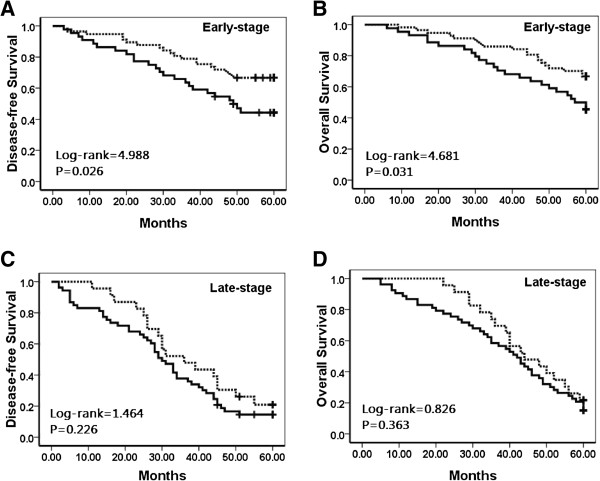
Kaplan–Meier analysis of survival rates in patients with high- or low-level NQO1 expression and with early- or late-stage cervical SCC. Disease-free survival (A) and overall survival rates (B) were assessed in patients with early-stage cervical SCC concomitant with either high- (solid, n = 44) or low-level (dashed, n = 57) NQO1 expression. Disease-free survival (C) and overall (D) survival rates were also assessed in patients with late-stage cervical SCC concomitant with high- (solid, n = 53) or low-level (dashed, n = 23) NQO1 expression.